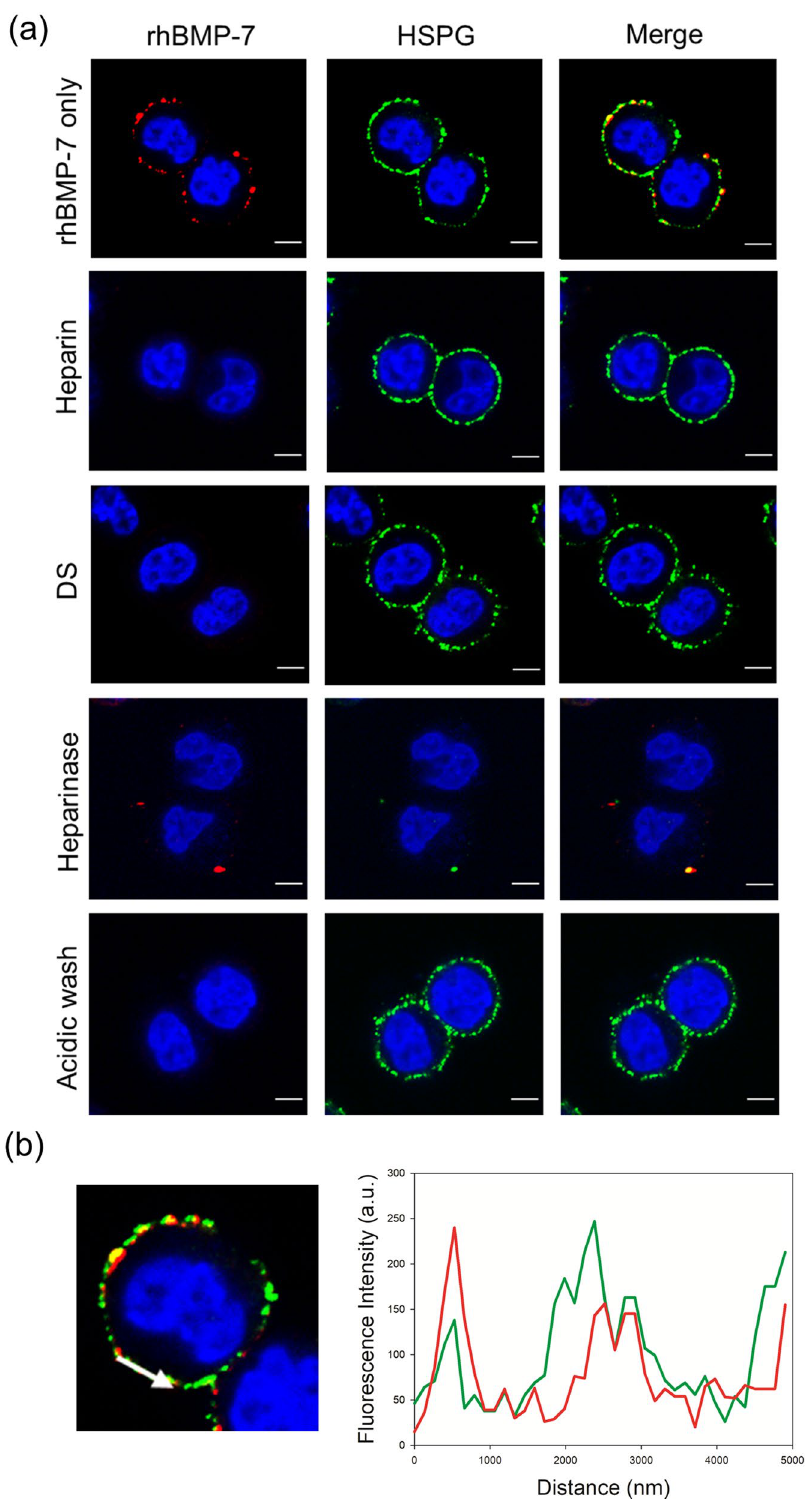
Figure 4. Binding of rhBMP-7 to cell surface HSPGs in DG44 cells. ( a ) Confocal microscopy to examine rhBMP-7 binding to cell surface HSPGs in the absence or presence of heparin and DS. Cells were incubated for 1 h at 4 °C with purified rhBMP-7 (10 μg/mL) alone or in the presence of heparin (0.1 g/L) or DS (0.5 g/L). Cells pre-treated with heparinase I/III (indicated a heparinase) and cells washed with acidic buffer (indicated as acid buffer) were also incubated for 1 h at 4 °C with purified rhBMP-7 alone. rhBMP-7 was stained red, while HSPGs were stained green. Nuclear counterstaining (blue) was carried out using DAPI. The merge image highlights colocalization (yellow) of rhBMP-7 and HSPGs. Scale bar, 5 μm. ( b ) The fluorescence intensity profile of HSPGs (green) and rhBMP-7 (red) across the arrow in a confocal image shown in Fig.